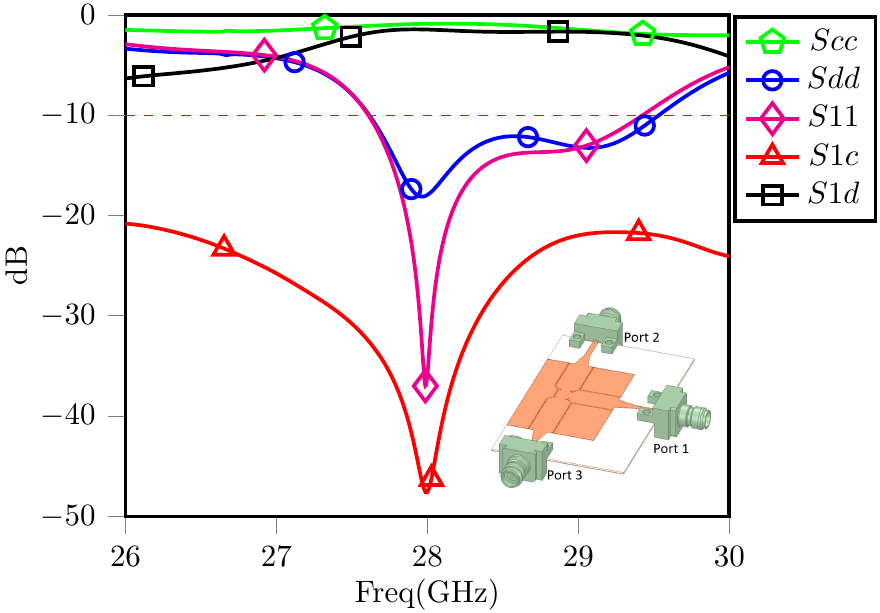
Figure 6. S-parameters of SIW power combiner with λ /2 SIW